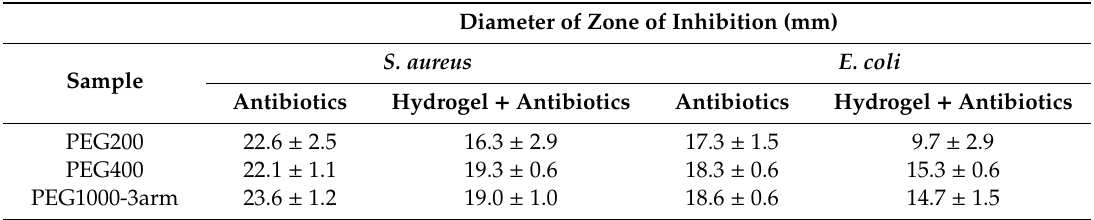
Table 2. Inhibitory effect of hydrogel discs loaded with antibiotics toward S. aureus and E. coli ( n = 3).